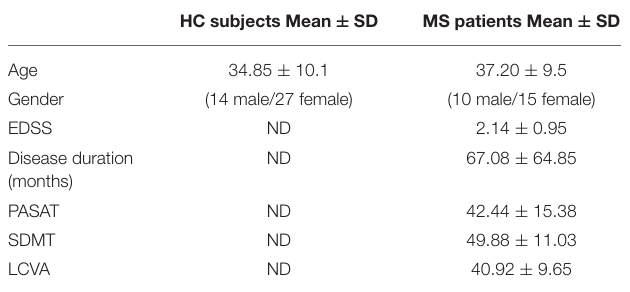
TABLE 1 | Demographics of MS patients. TABLE 2 | The 38 ROIs (FreeSurfer version 4.5.0) in the study (19 bilateral